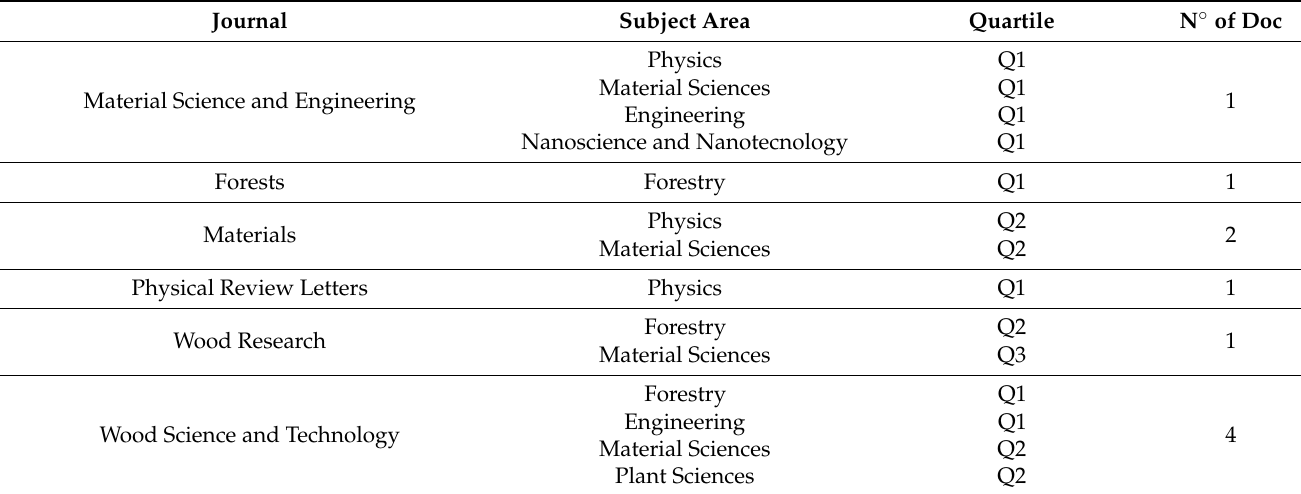
Table 3. Journal’s names, corresponding main subject areas, journal’s quartile and number of published documents for each journal.